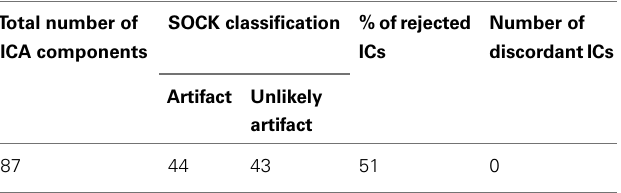
Table 4 |A summary of the SOCK classification for one (Subject 4) of the 30 subjects.